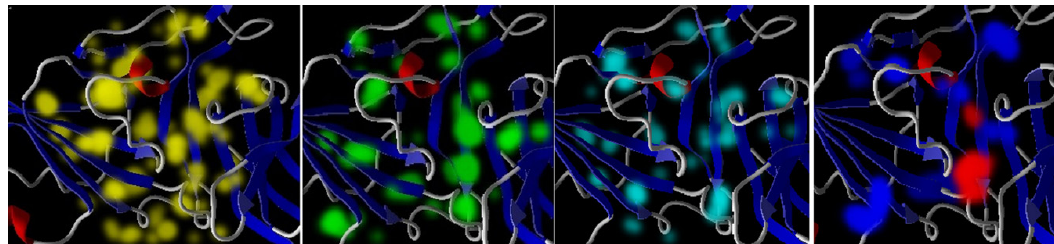
Fig. 2. Energy map of VHH 17B-RBD complex; a) hydrogen donor b) steric, c) hydrogen acceptor, and d)